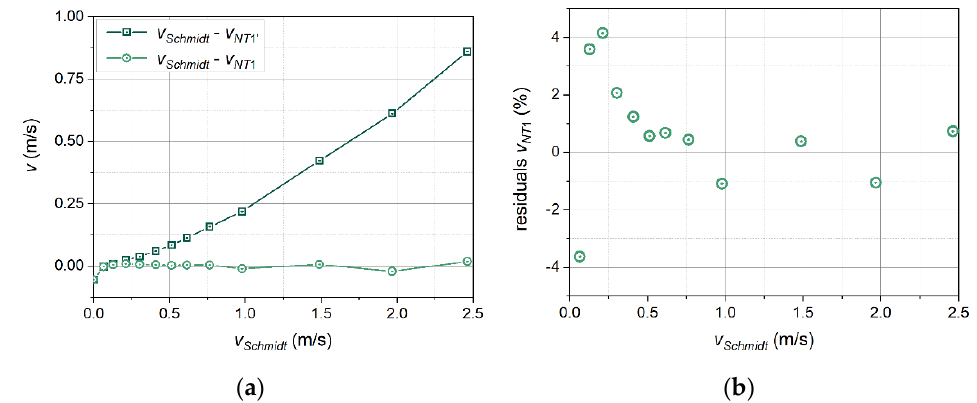
Figure 13. Differences in velocity values between measurements and inflow velocity ( a ) and residuals of measurement with correction ( b ). The measurement results are marked with squares, and the measurement results after applying the correction are marked with circles.